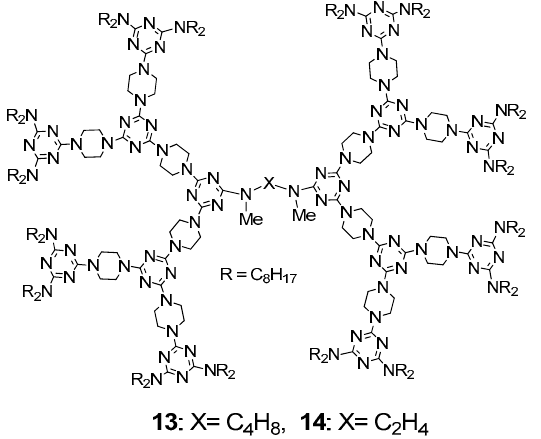
Figure 8. Structures of dendrimers ( 13 ) and ( 14 ).